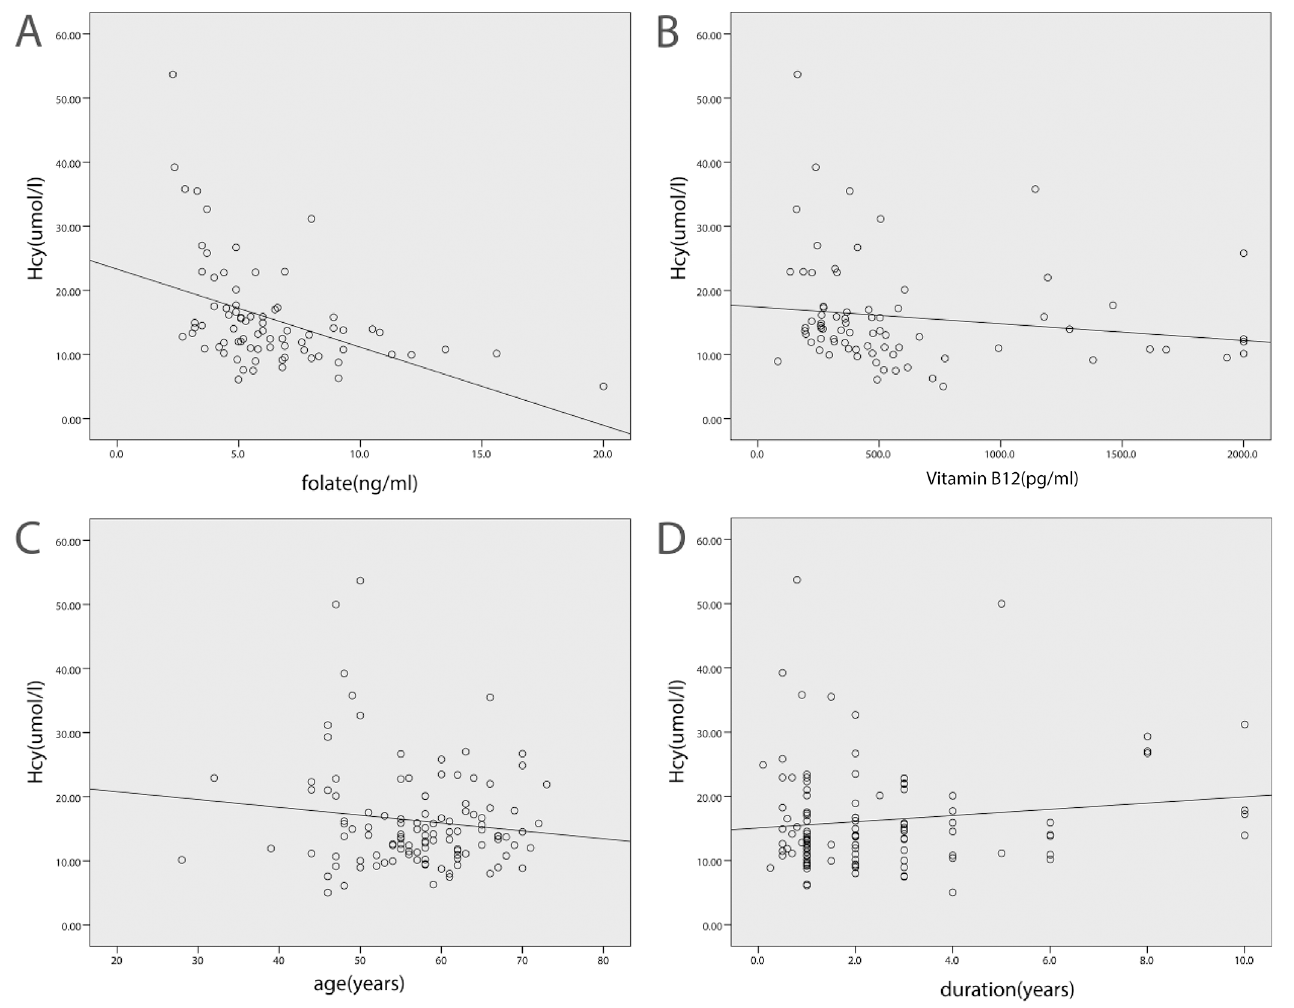
Fig 1. Correlation analysis between Hcy and folate, vitamin B12, age, disease duration respectively in MSA patients. (A): Hcy levels were significantly negative correlate with folate in MSA patients; (B): Hcy levels were significantly negative correlate with vitamin B12 in MSA patients; (C): Hcy levels were not significantly correlate with age in MSA patients; (D): Hcy levels were not significantly correlate with disease duration in MSA